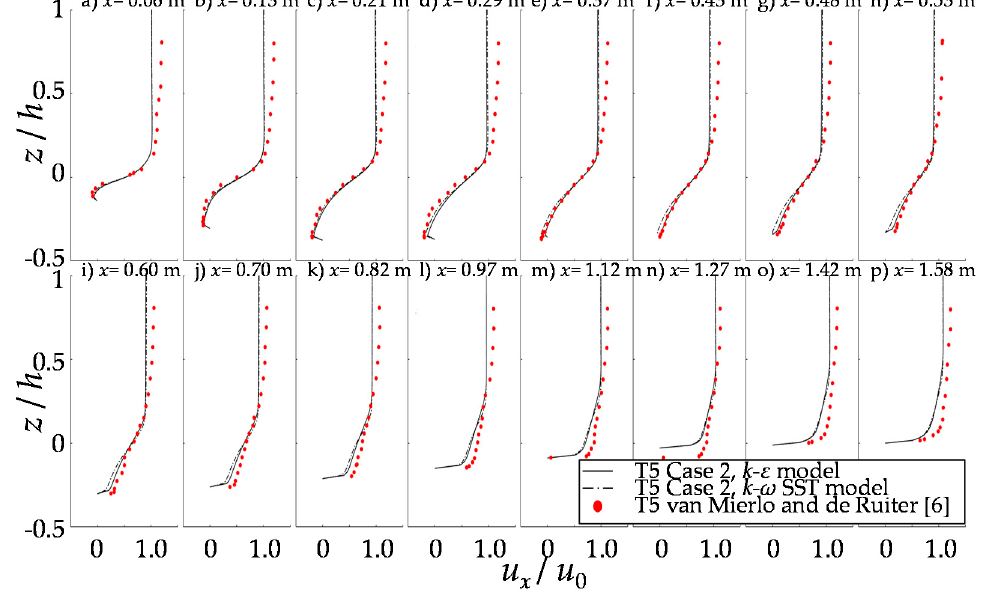
Figure 3. Comparison of different turbulence schemes in nondimensional stream-wise velocity with experimental data for Case 2 ( k s = 1.6 D 50 ).